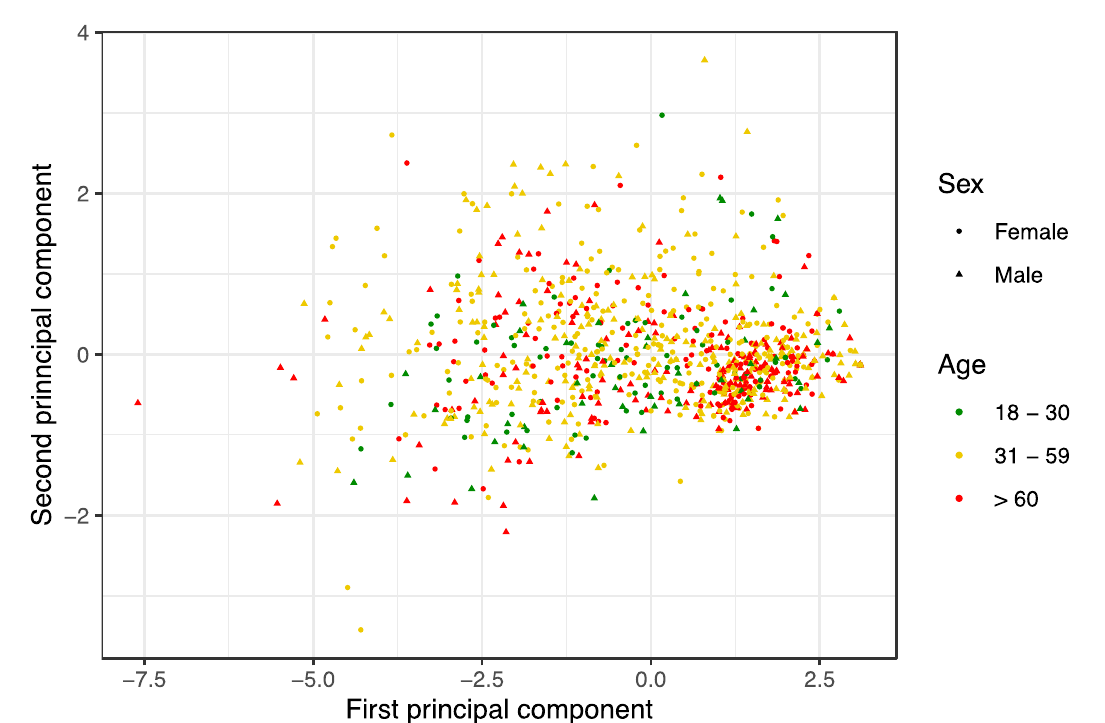
Figure 3. Scatter plot for the two first principal components according to age group and gender. The first principal component explains 70.2% of data variability, and both together account for 81.2%. Note that the consumers aged 60 years and older tend to give high values on the first PC. The very high values of the second PC correspond to consumers who have given high scores for professionalism and market hygiene (i.e., low demand for these aspects) but low values to the prices (i.e., disagreement with the prices).